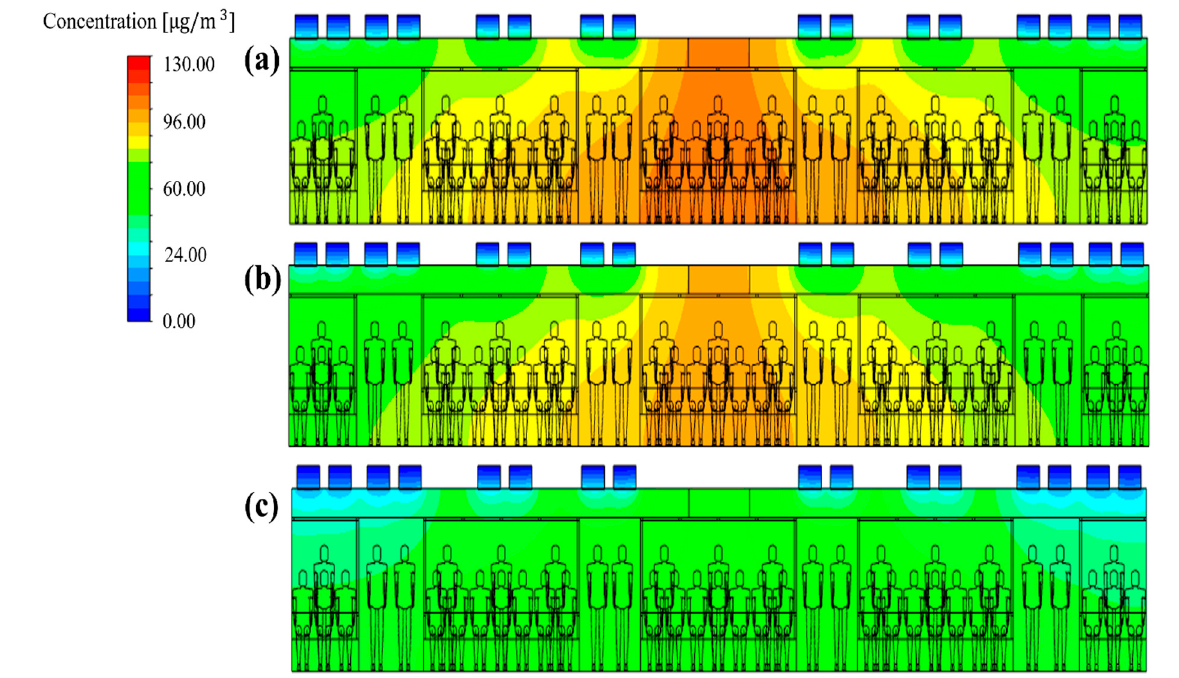
Figure 14. PM 10 concentration distribution in the subway cabin according to the total ventilation flow rate (filter efficiency of 80% and flow rate ratio of 20:20:60 applied): ( a ) 500 CMH (case 2); ( b ) 600 CMH (case 29); ( c ) 700 CMH (case 30).